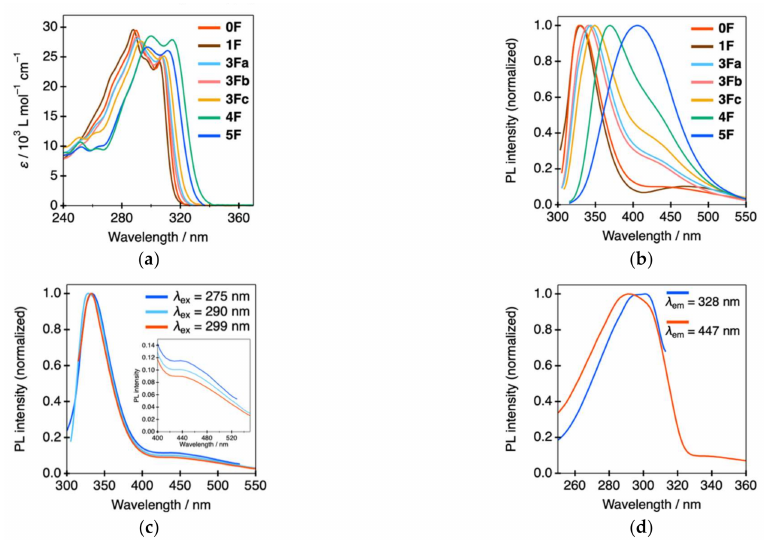
Figure 3. ( a ) UV–vis spectra of 0F – 5F ; ( b ) photoluminescence (PL) spectra of 0F – 5F excited at ( λ abs ) 290 nm for 0F , 288 nm for 1F , 291 nm for 3Fa , 290 nm for 3Fb , 293 nm for 3Fc , 300 nm for 4F , and 297 nm for 5F ; ( c ) PL spectra of 0F at various excitation wavelengths; and ( d ) excitation spectra of 0F at 328 and 447 nm. Table 1. Photophysical properties of tolanes 0F – 5F in dilute THF solution (concentration: 1.0 × 10 –5 mol L –1 ).